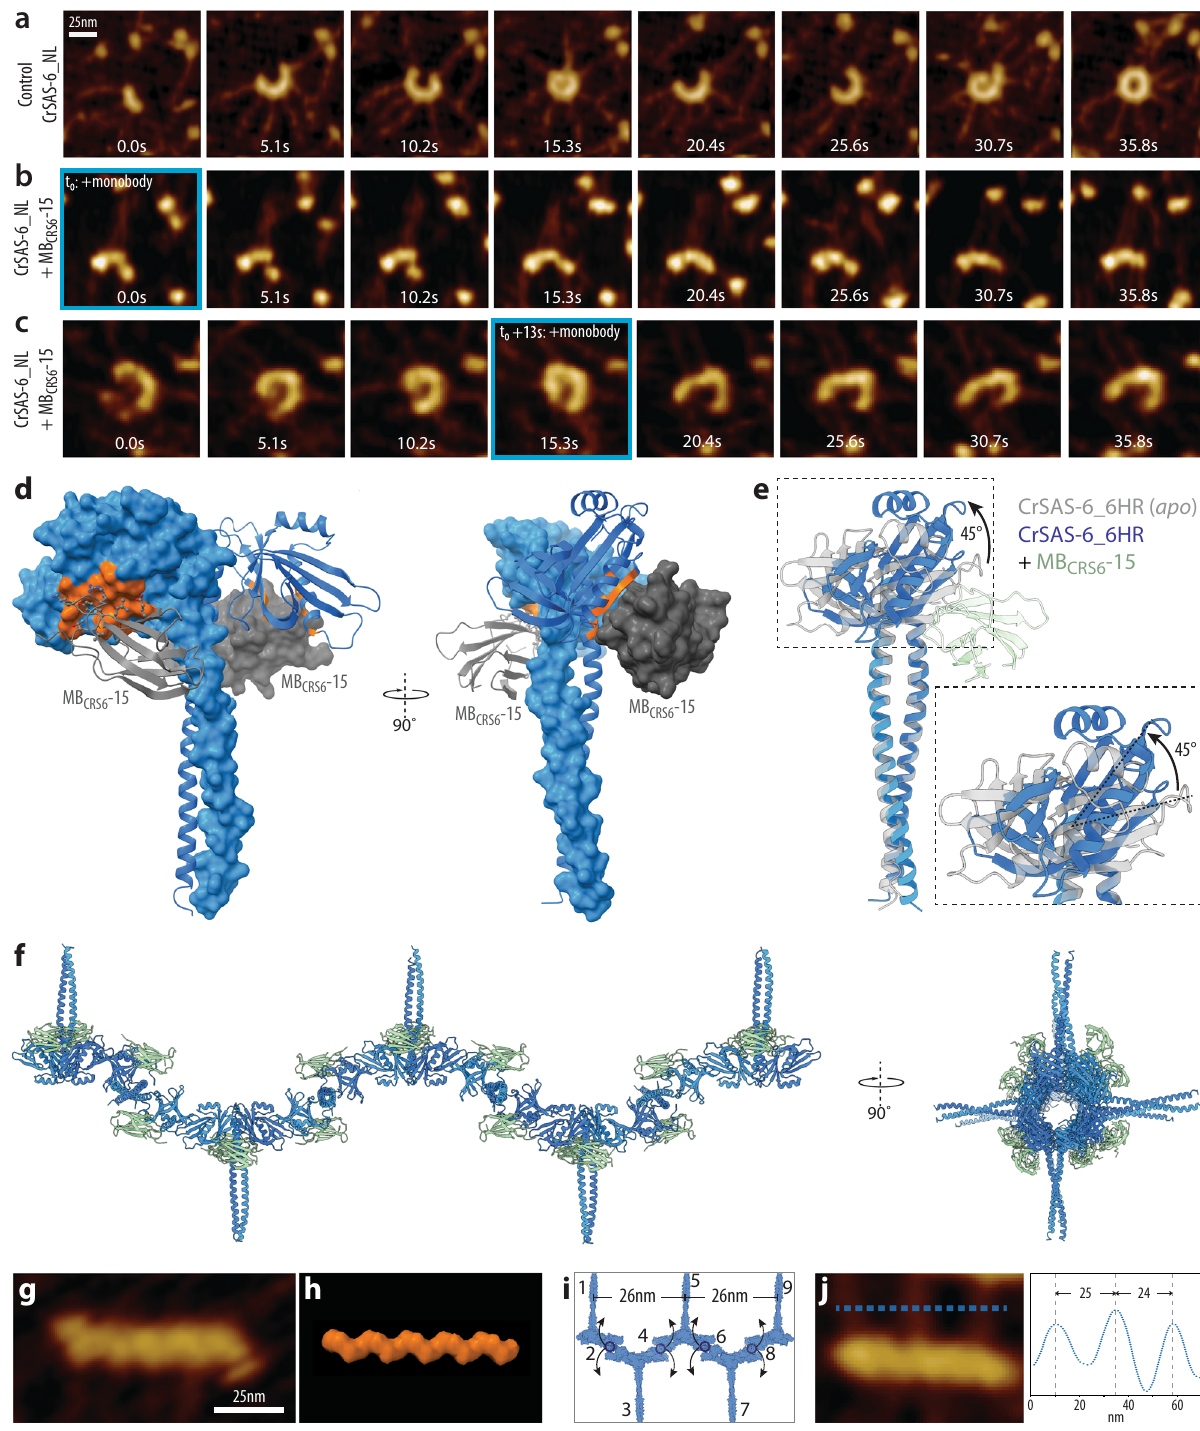
the formation of a helix instead of a ring upon higher order